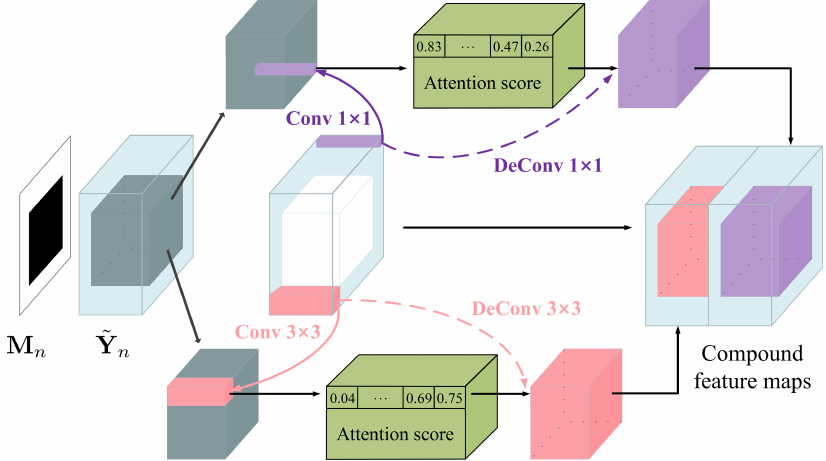
Figure 2. The schematic illustration of the multi-scale contextual attention (MSCA)